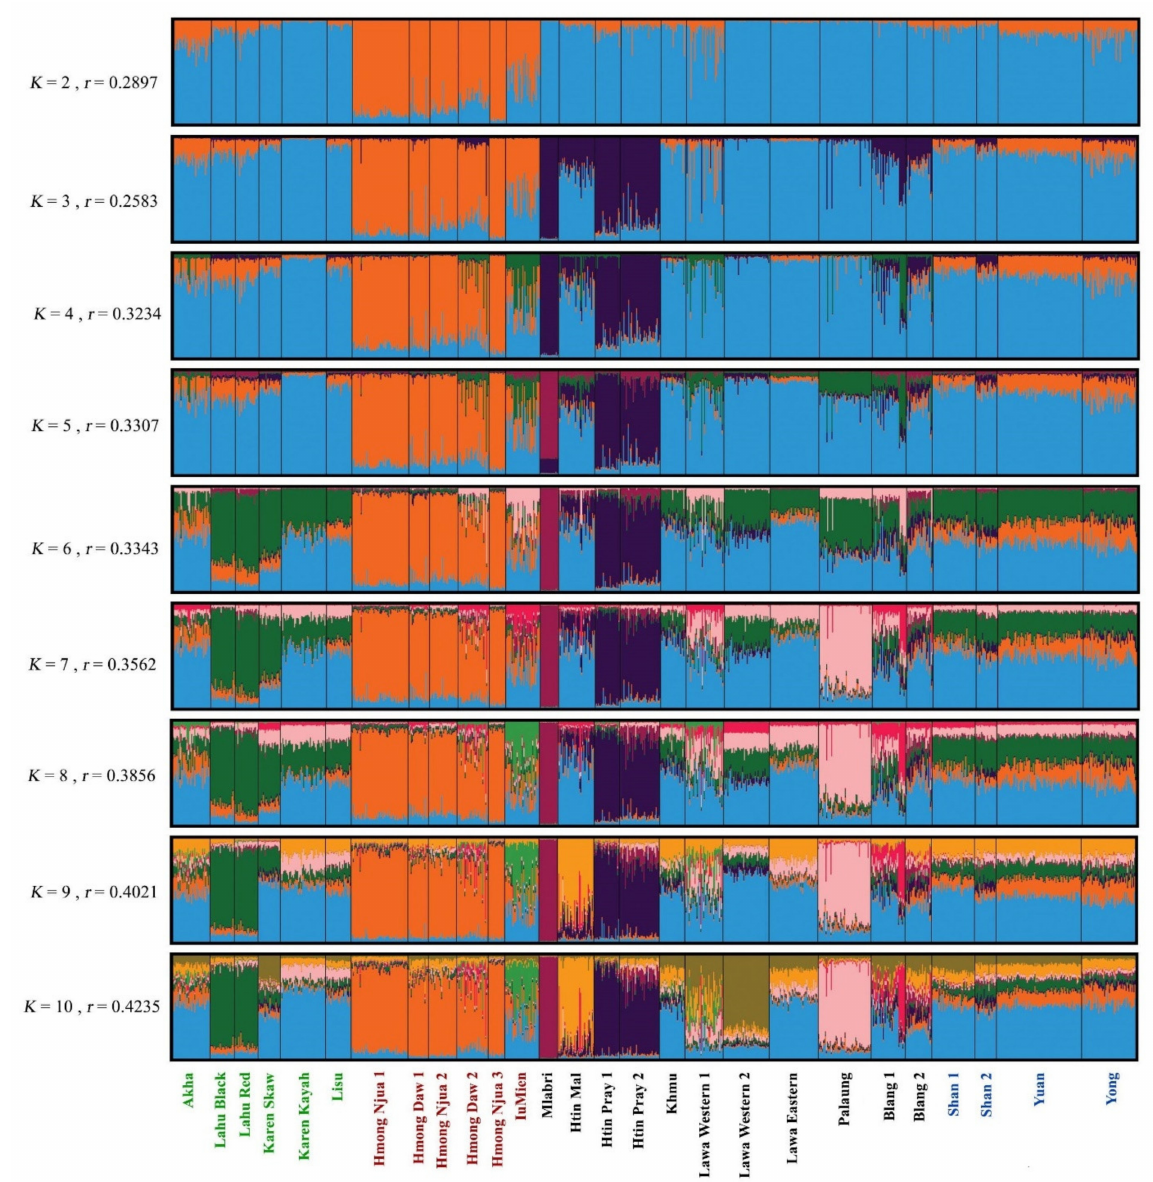
Figure 4. The STRUCTURE result from K = 2 to 10. Each individual population is represented by a single column divided into segments whose size and color correspond to the relative proportion of a particular cluster. Populations are separated by black lines. Population names are color-coded according to language family; red, green, black, and blue represent HM-, ST-, AA-, and TK-speaking populations, respectively. K and r are the number of clusters and parameter which estimates the informativeness of the sampling location data,